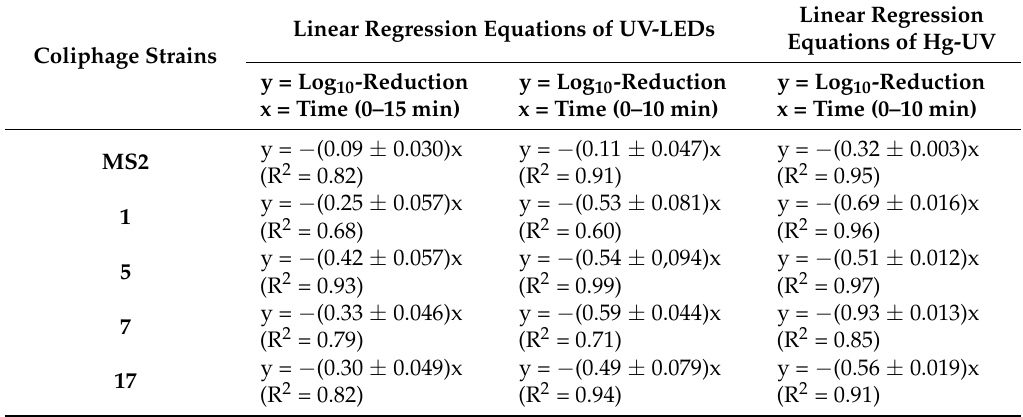
Table 2. Linear regression equations for inactivation of coliphages using UV-LEDs for 0–15 and 0–10